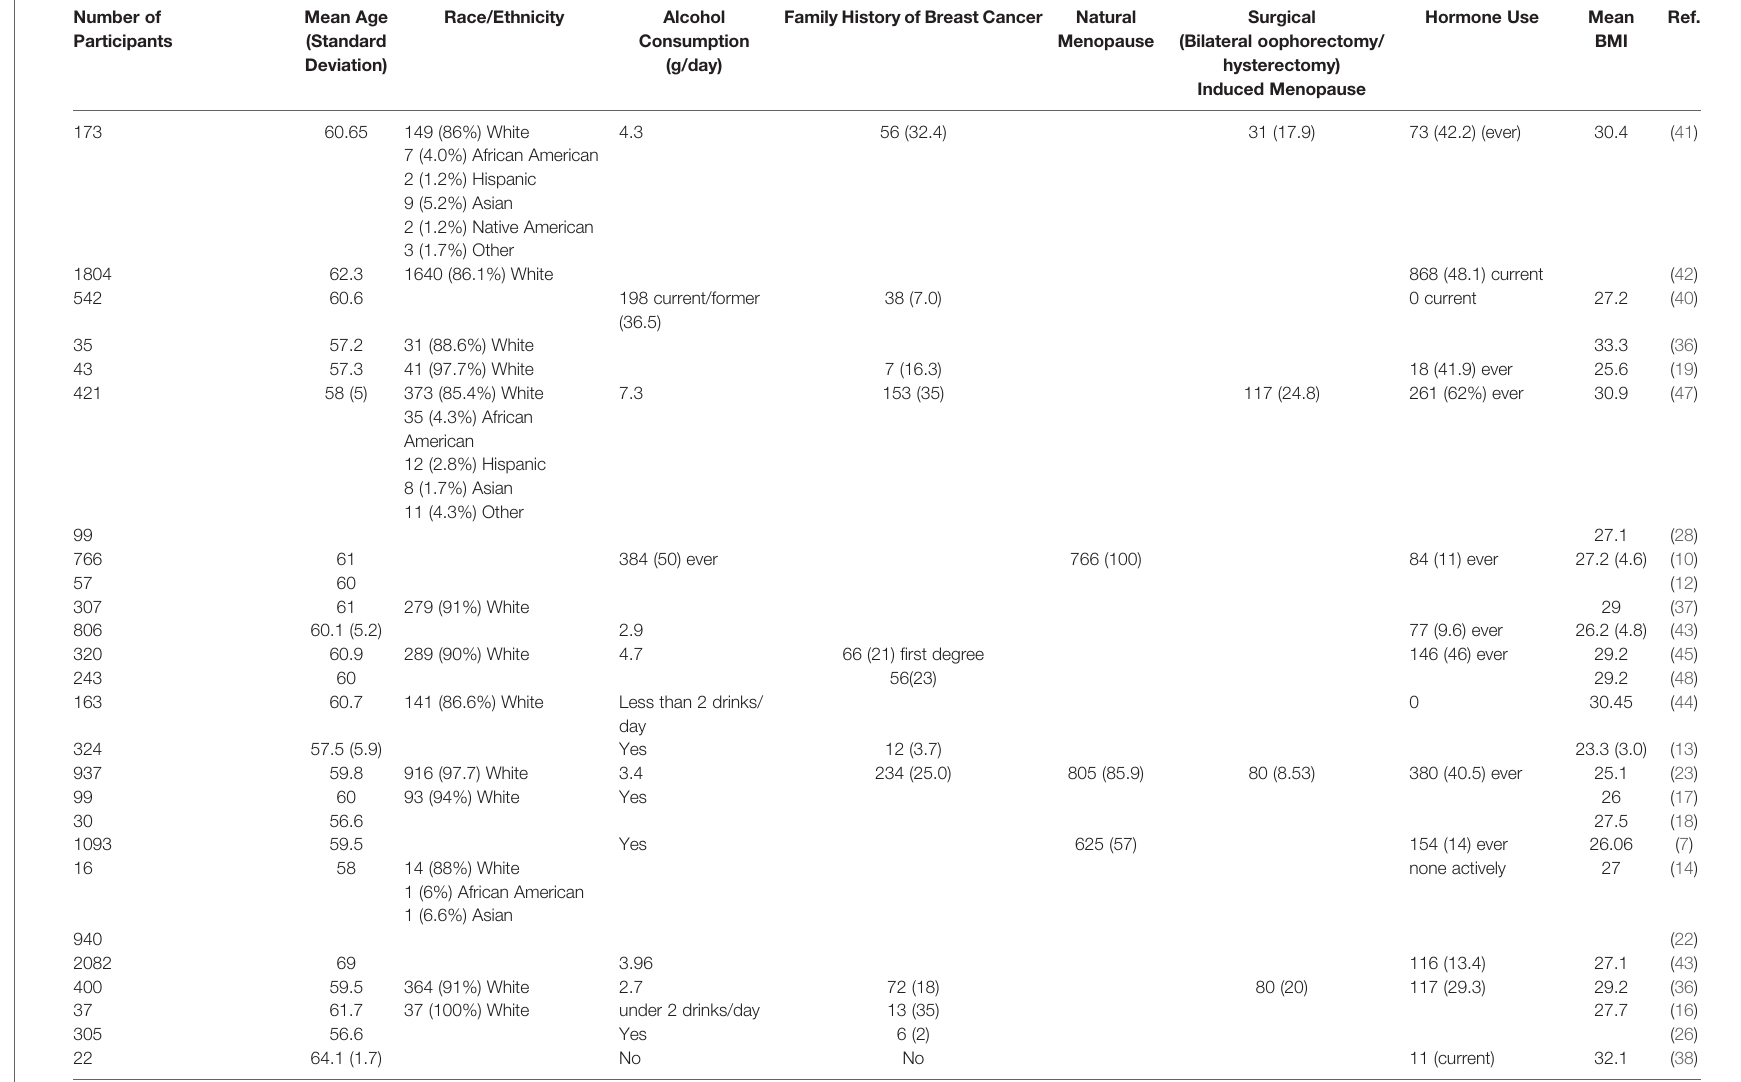
TABLE 2 | Demographics and clinical characteristics of the study participants of the eligible studies. Number of